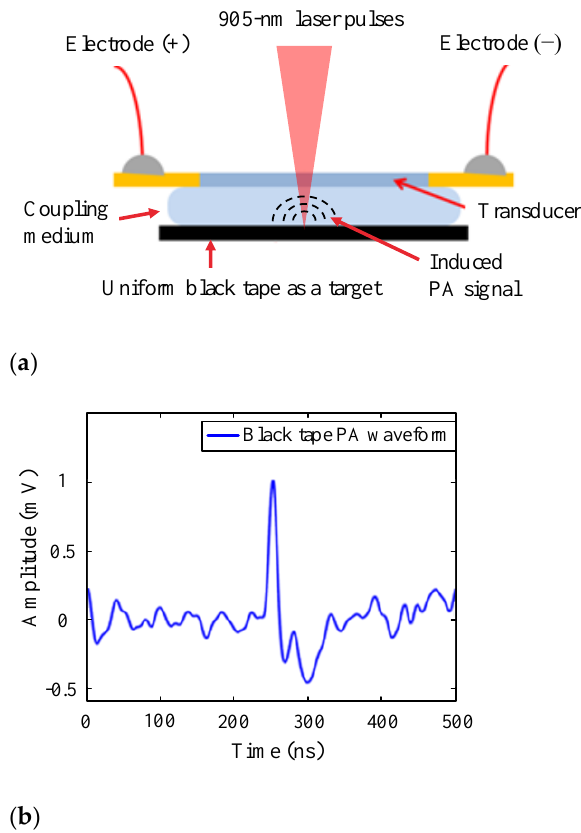
Figure 3. ( a ) Measurement setup for the PA response of the PVDF transducer; ( b ) recorded PA signal induced by laser pulse onto black